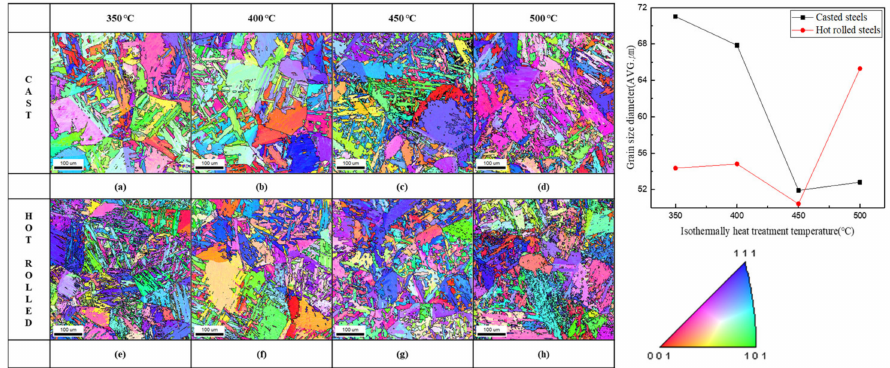
Figure 8. EBSD orientation maps and grain sizes of medium-carbon low-alloy steel isothermally heat treated for 240 min: cast steel heat treated at ( a ) 350 ◦ C, ( b ) 400 ◦ C, ( c ) 450 ◦ C, and ( d ) 500 ◦ C and hot-rolled steel heat treated at ( e ) 350 ◦ C, ( f ) 400 ◦ C, ( g ) 450 ◦ C, and ( h ) 500 ◦ C. High KAM values in yellow-green, excluding red, indirectly indicate the dislocation density due to strain. As shown in Figure 9 KAM maps, the cast steel had a similar dislocation density distribution at 350 and 400 ◦ C. However, as the temperature increased to 450 ◦ C, a high dislocation density was observed, and a red region caused by M was also identified. This is because the M phase fraction was high at 450 ◦ C. At 500 ◦ C, a lower dislocation density was observed. The change in the distribution of dislocation density with the heat-treatment temperature of the hot-rolled steel was similar to that of the cast steel, but the dislocation density was higher. In line with this, it has been shown that numerous carbon clusters exist in BF, which is related to the low solubility of carbon atoms in the body-centered cubic (BCC) matrix. This is also the reason the carbon clusters in BCC-structured BF tend to pin dislocations and interfere with the slip behavior. This leads to strain concentration around the carbon clusters, resulting in high KAM values [35–37].